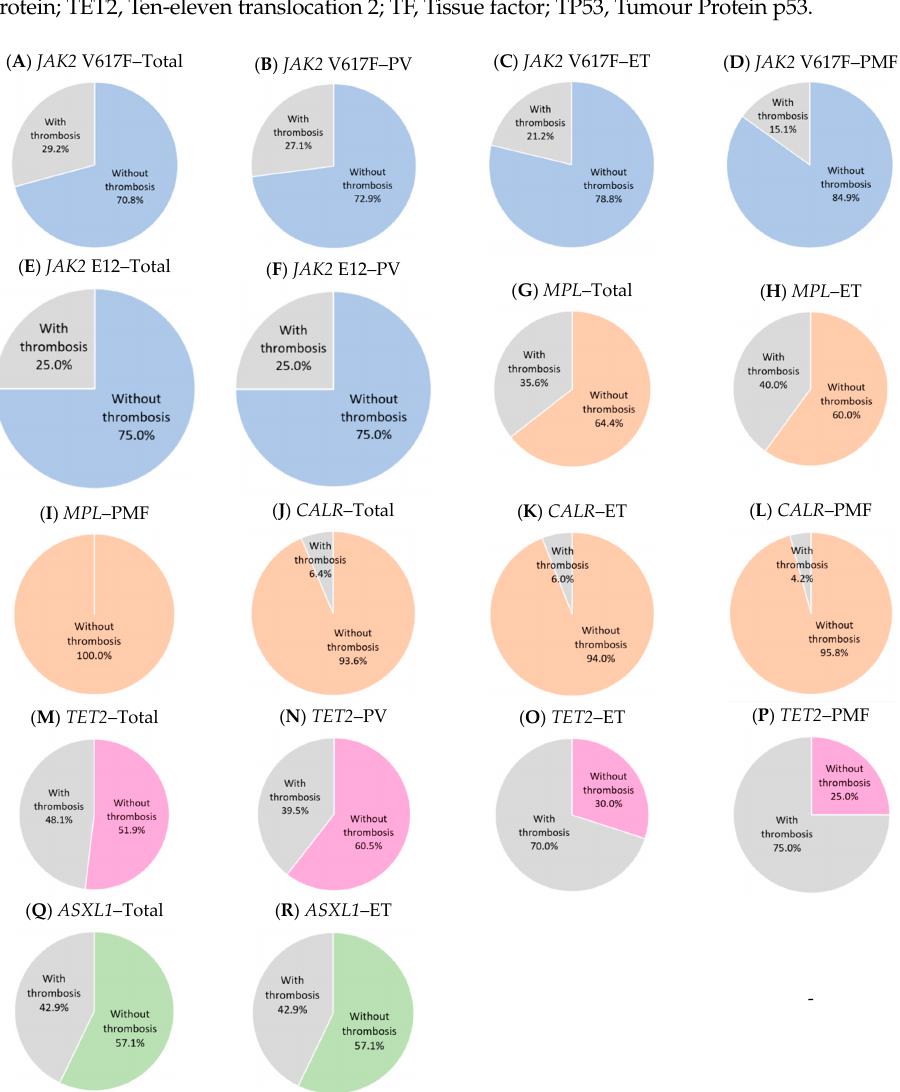
Figure 2. Thrombotic MPN patients with different gene mutations. ( A – F ) Tyrosine kinases. ( G – L ) Receptors. ( M – P ) DNA methylation. ( Q , R ) Histone methylation. Abbreviations: ASXL1: Additional Sex Combs Like 1, CALR : Calrecticulin, ET: Essential thrombocythaemia, JAK2 : Janus kinase 2, PMF: Primary myelofibrosis, MPL : Myeloproliferative leukaemia virus oncogene, PV: Polycy- thaemia vera, TET2 : Ten-eleven translocation 2.